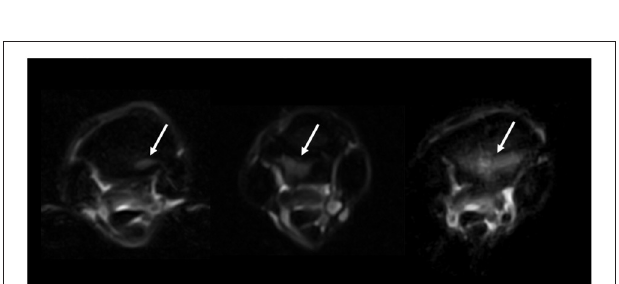
FIGURE 1 | Grading of the hyperintensity within the dorsal collagenous part of the proximal suspensory ligament as seen on T1W GRE transverse images (from left to right, grades 1, 2, and 3 identified by the white arrows). The transverse images are 2–3cm distal to the carpometacarpal joint, and all images are from limbs within the lame group.